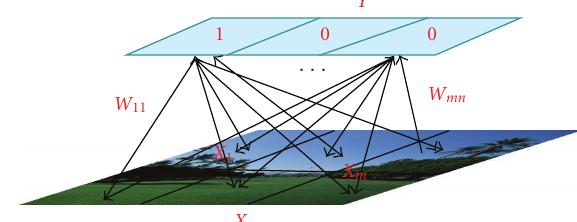
Figure 2: Structure of